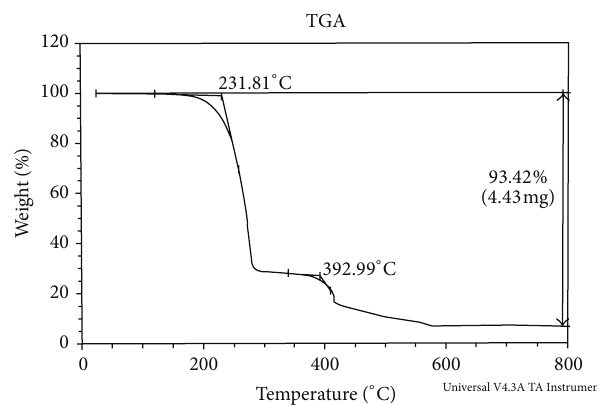
Figure 5: Thermogram of Co(II) complex.